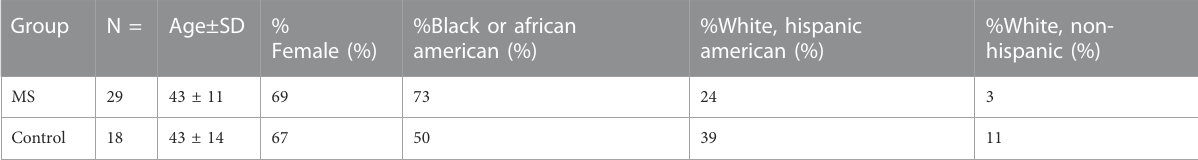
(Supplementary Figure S1) did not yield any statistically signi fi cant associations (FDR > 0.18 for the Hispanic-Latino group and FDR > 0.68 for the Black American